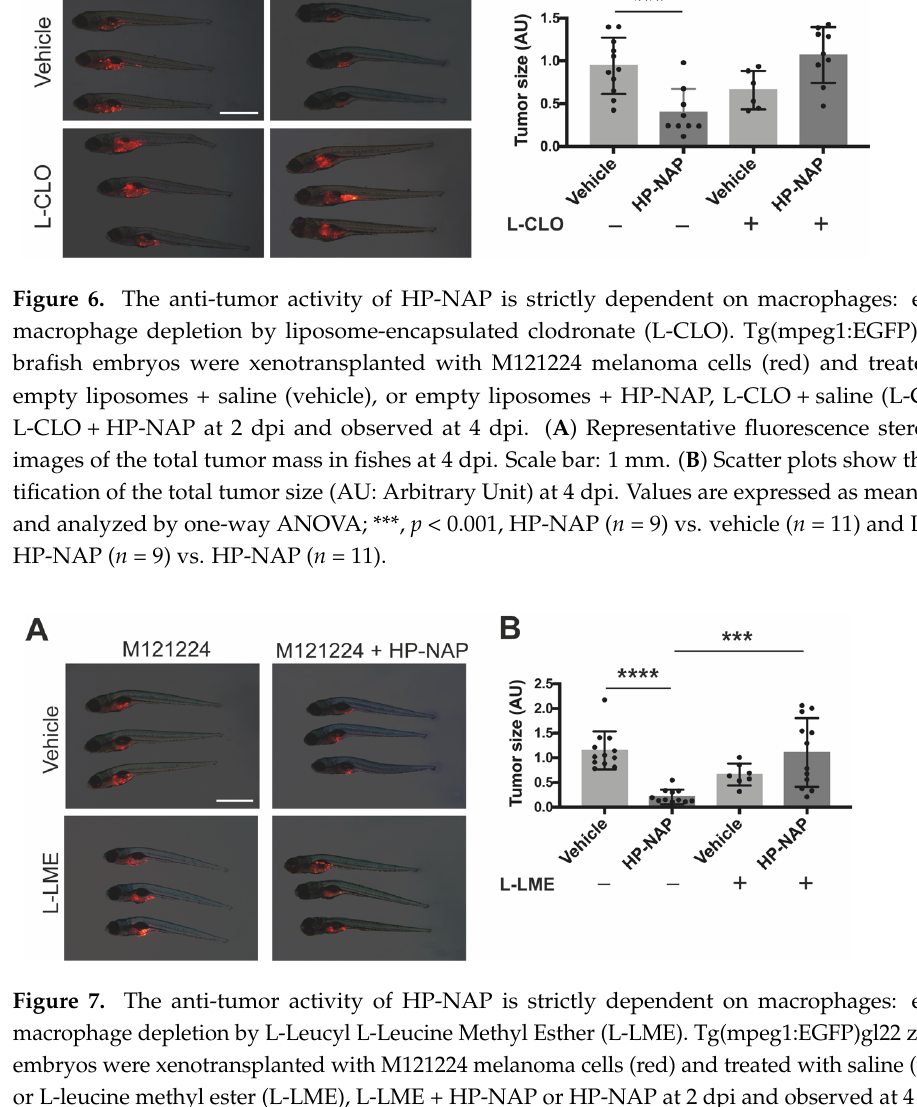
Figure 5 . HP ‐ NAP administration in zebrafish promotes the acquisition of a pro ‐ inflammatory profile by macrophages . Tg(mpeg1:EGFP)gl22 zebrafish embryos were xenotransplanted with M121224 melanoma cells and treated with HP ‐ NAP or saline (vehicle) at 2 dpi. After 24 h (3 dpi)